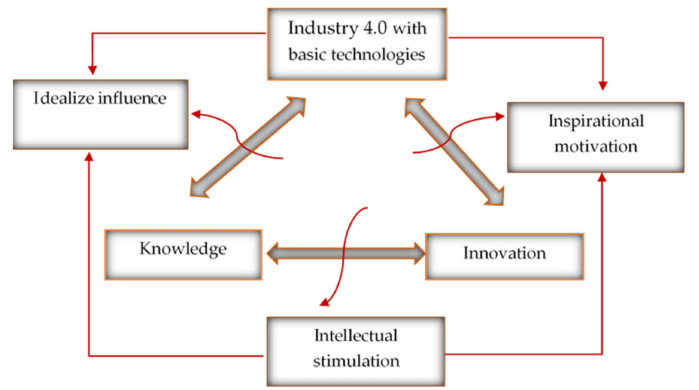
Figure 1. Framework of leadership leading to the compatibility with Industry 4.0. Source: own